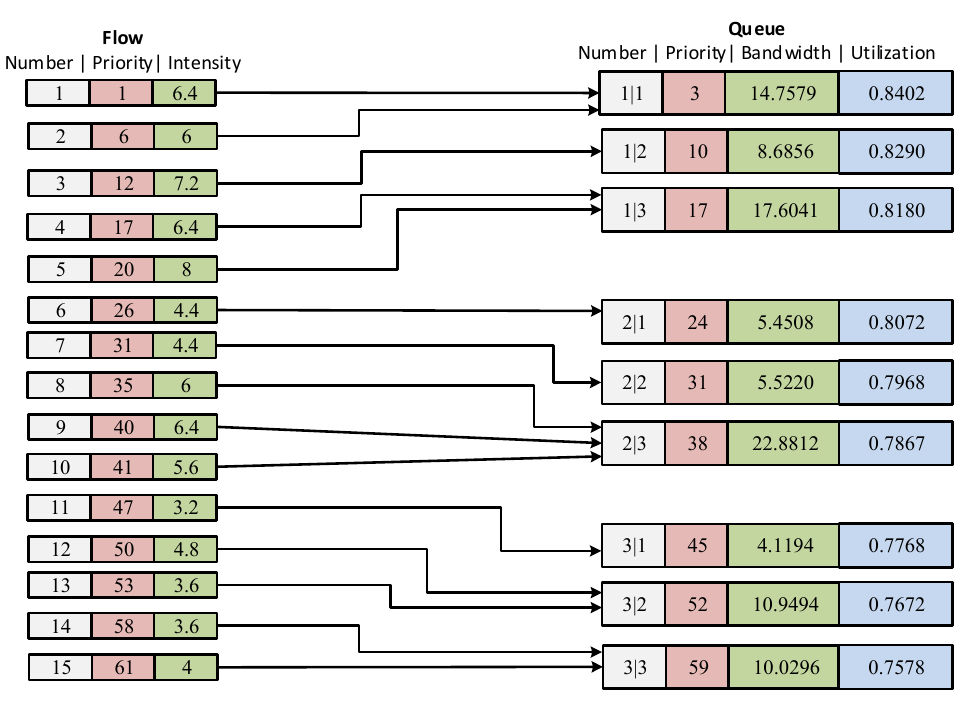
Table 8. Dependence of the minimum value D on the interface utilization and number of macro- queues organized on the interface. Interface Uti- lization